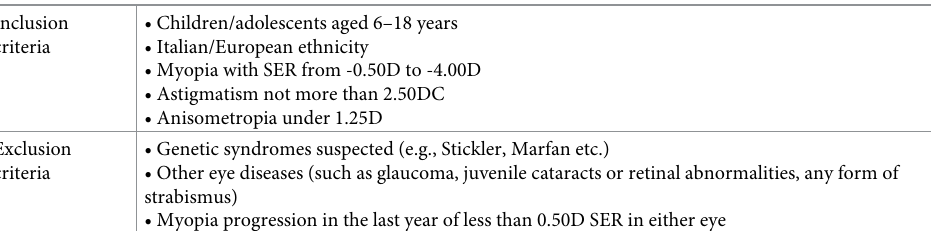
Table 1. Selection